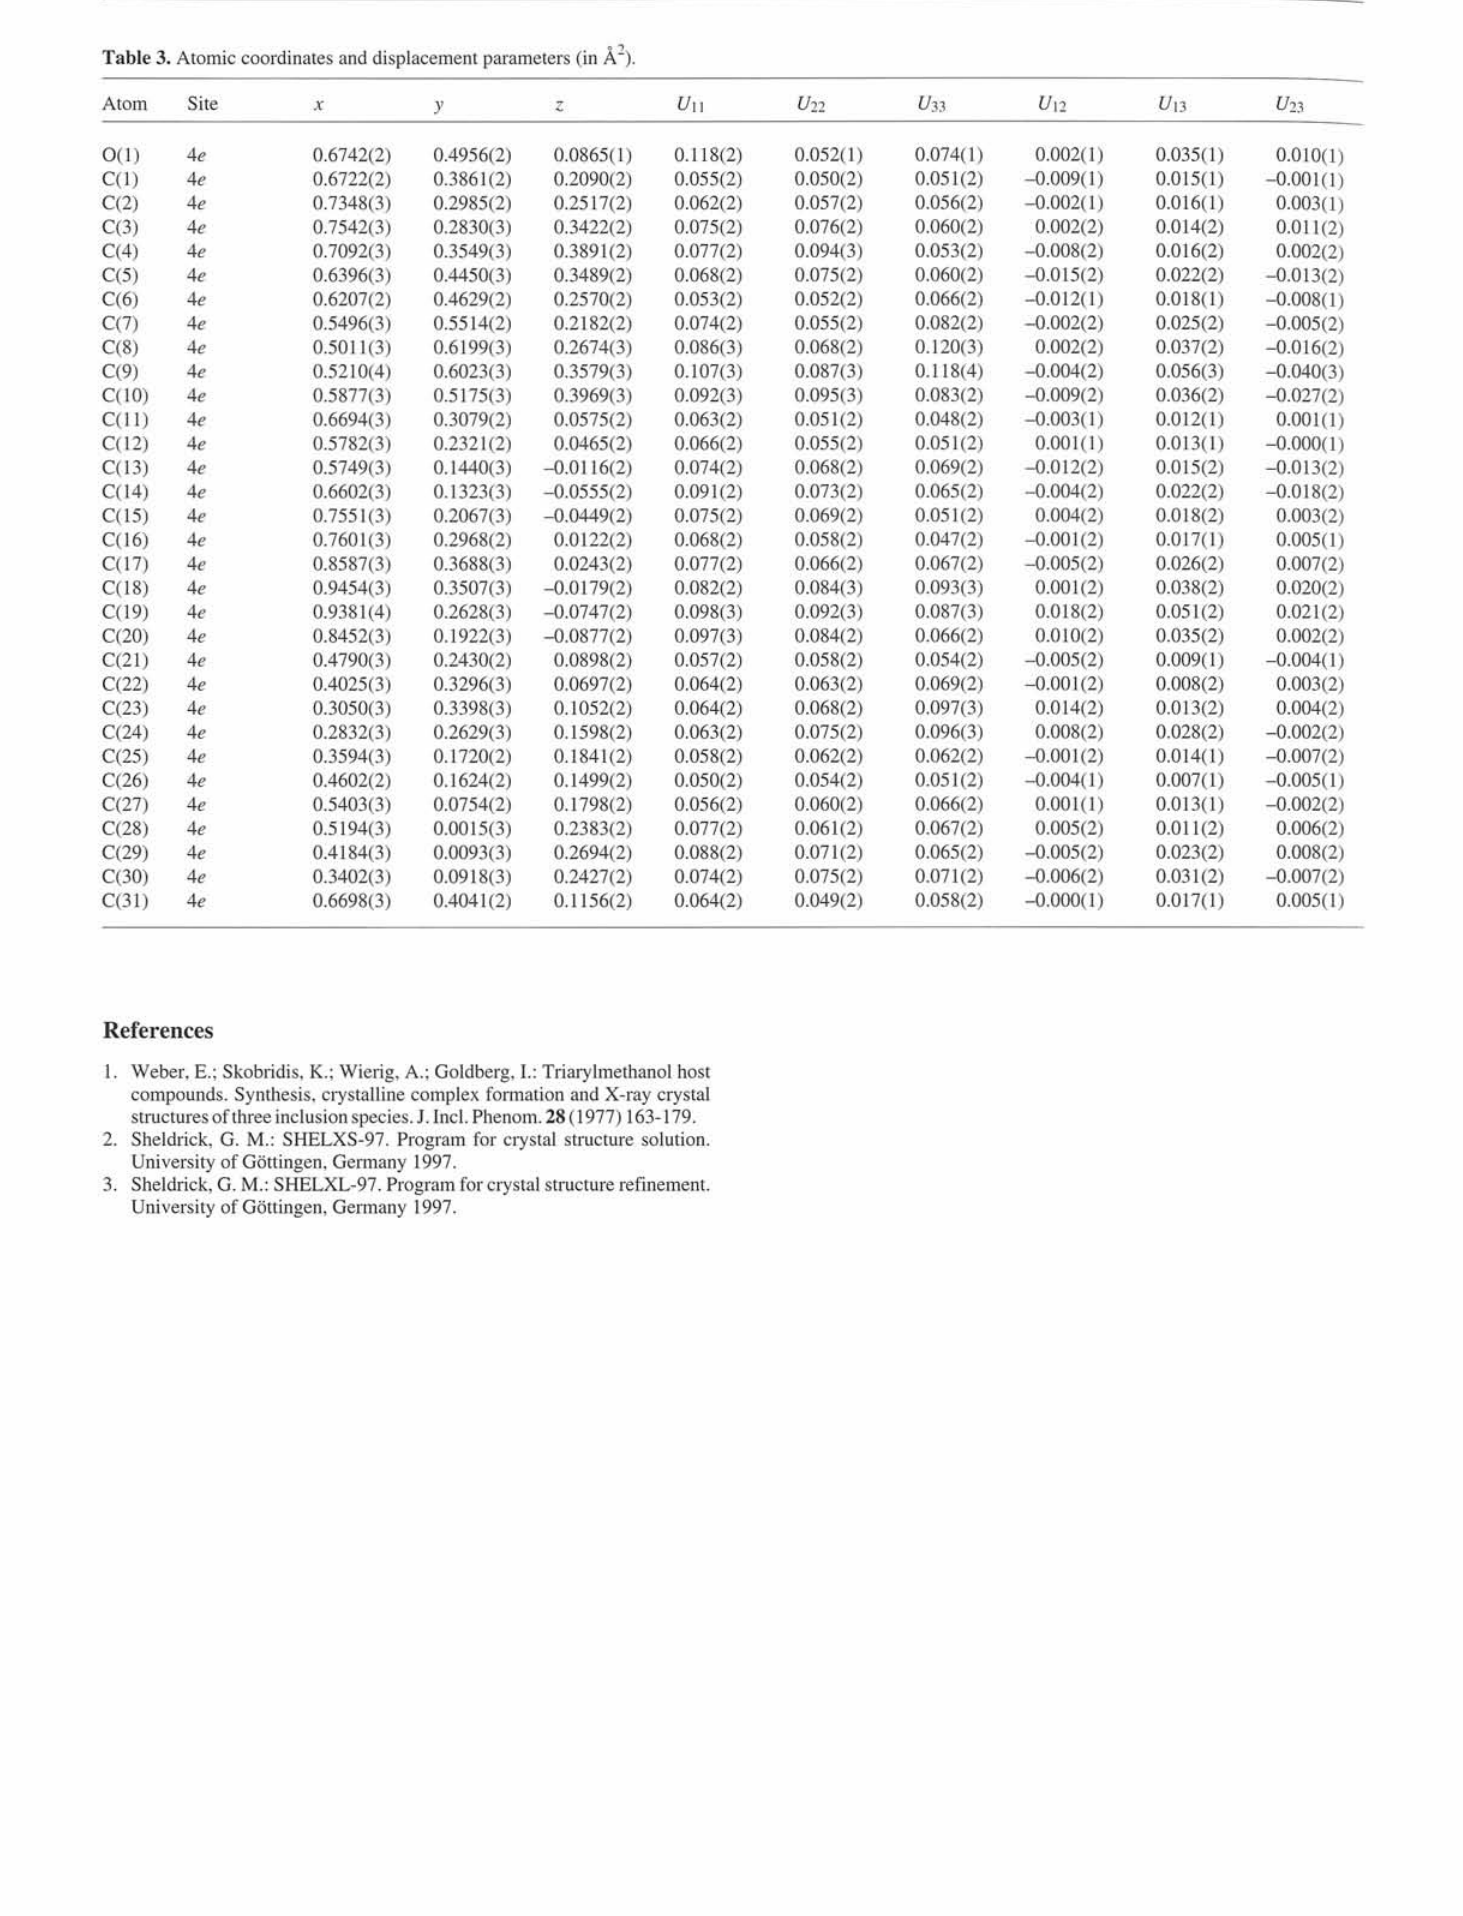
Table 3. Atomic coordinates and displacement parameters (in Atom